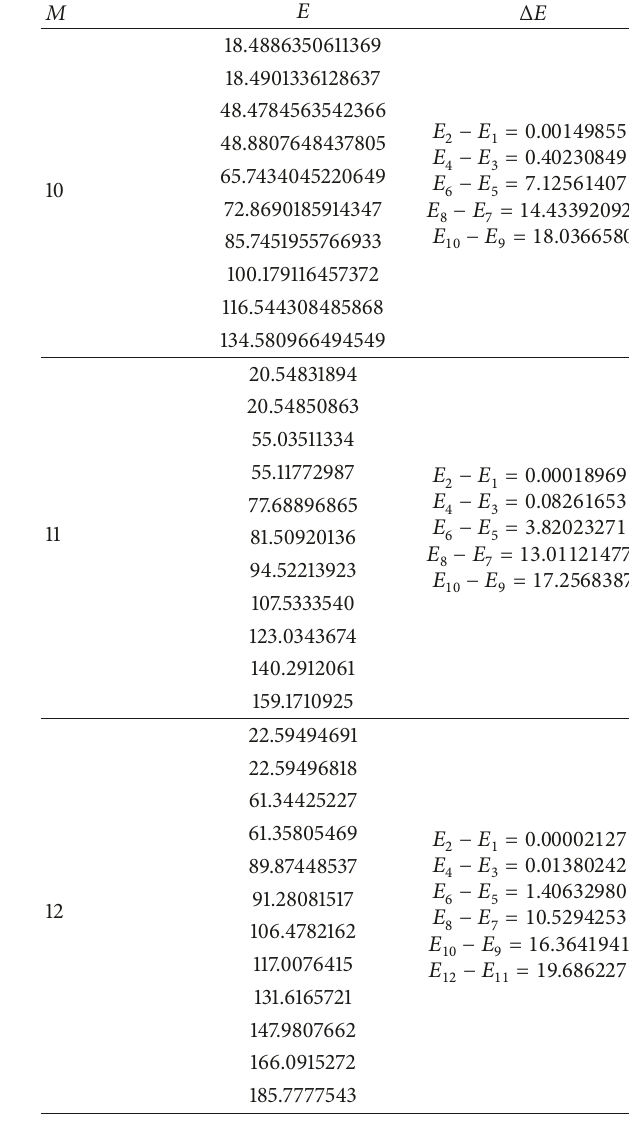
Table 3: Energy splitting of the first 12 states for the Razavy bistable potential with 𝜉 = 2